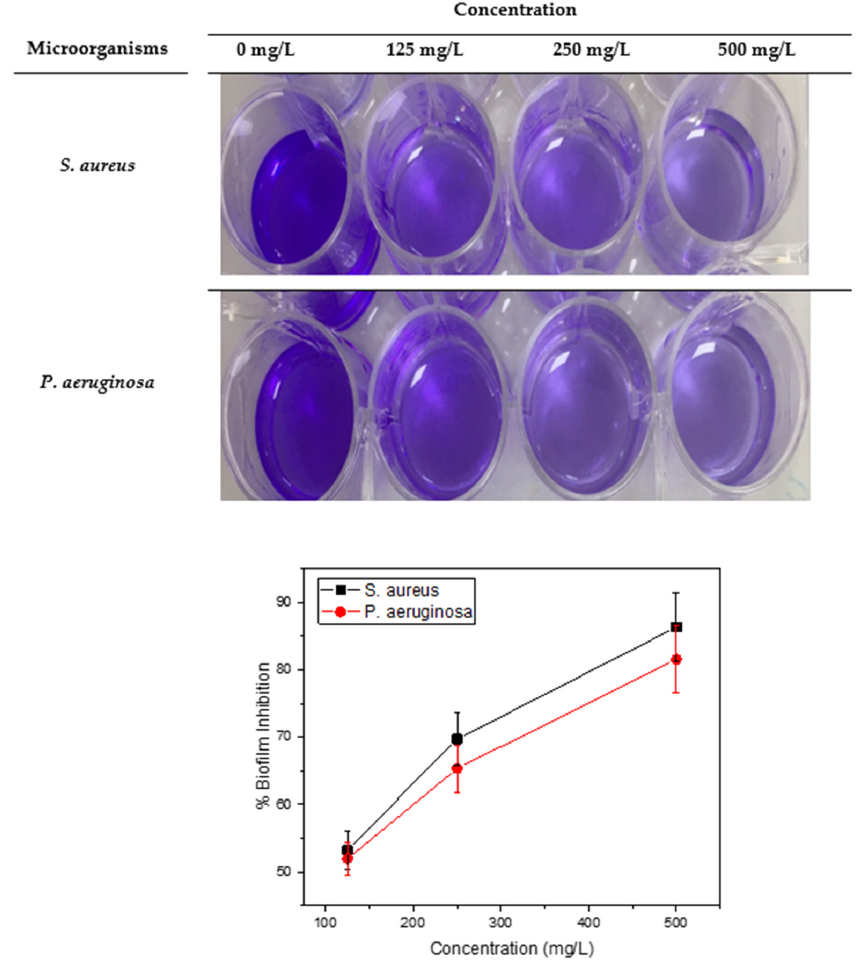
Figure 7. Biofilm inhibition of γ‐ Fe 2 O 3 ‐ CA ‐ Leu ‐ Gly ‐ PDX.